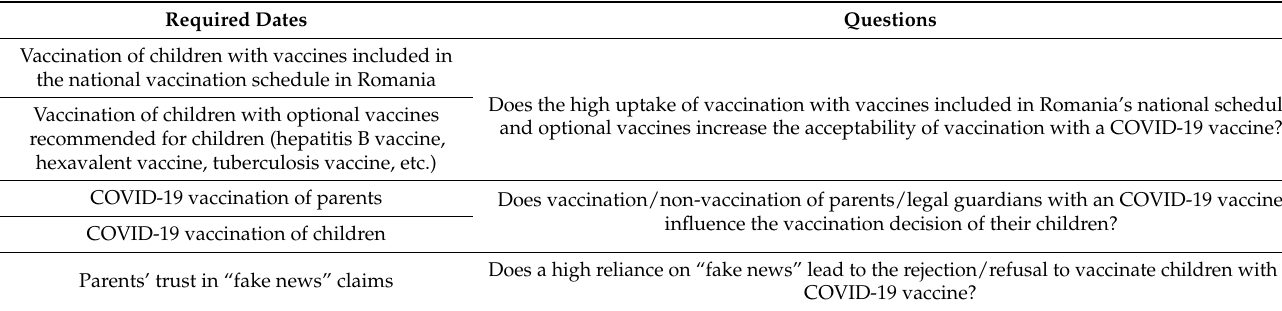
Table 1. Required dates and research